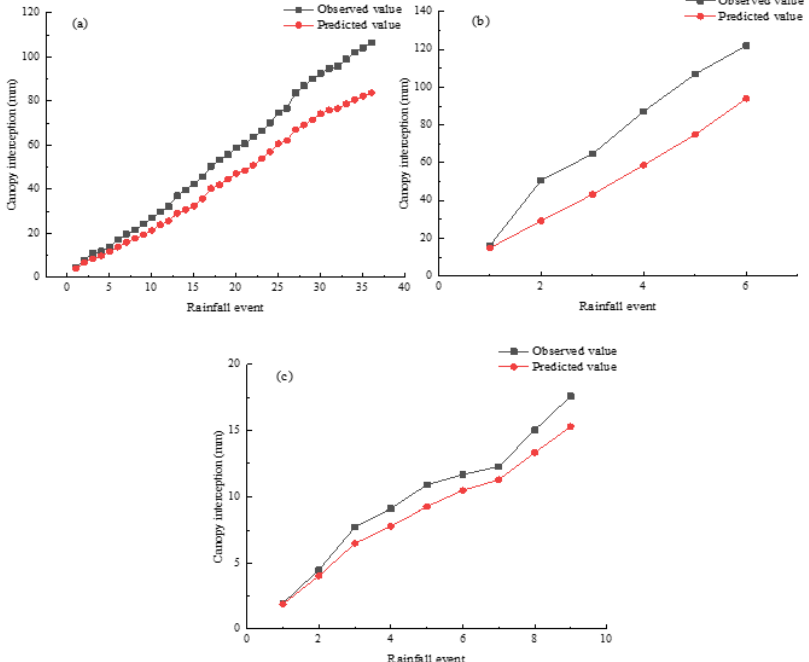
Figure 6. Comparison of cumulative observed and predicted canopy interception. ( a ): Rainfall pat- tern A; ( b ): rainfall pattern B; ( c ): rainfall pattern C. pattern A; ( b ): rainfall pattern B; ( c ): rainfall pattern